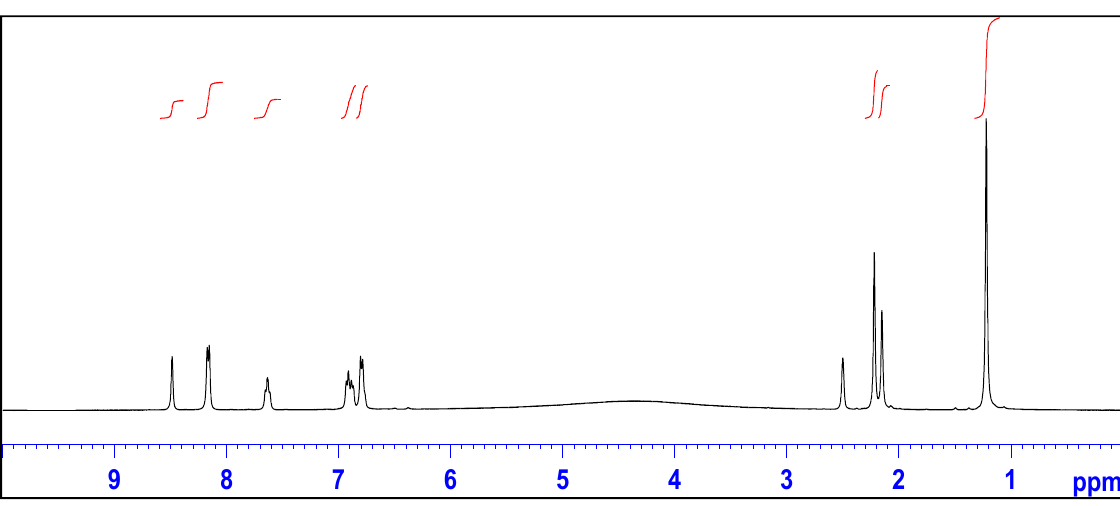
Figure 1. 1 H-NMR spectrum of 2,2,4-trimethyl-2,3-dihydro-1 H -1,5-benzodiazepin-5-ium isophthalate ( I